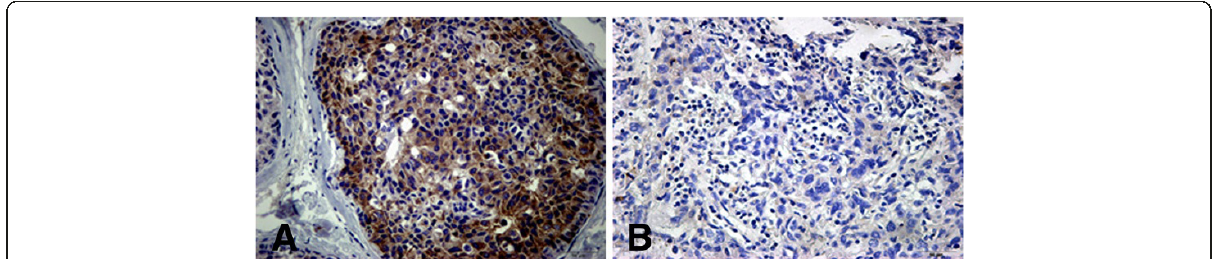
Table 3 The correlation between the expression of claudin-6 and ASK1 in breast invasive ductal carcinomas ASK1 expression